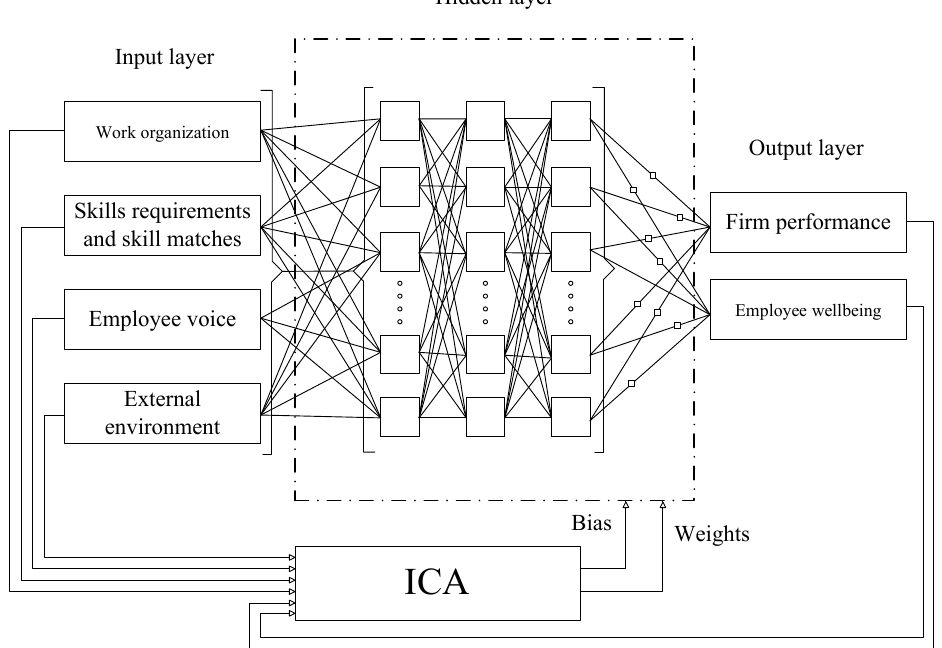
Figure 3. The architecture of the proposed method.